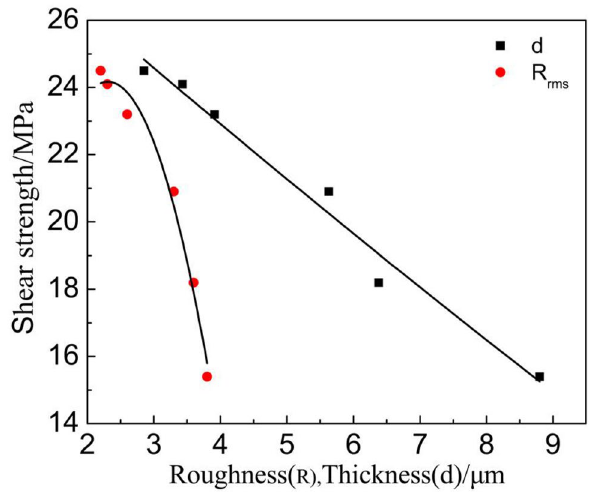
Figure 12. Relationship between shear strength and d, R rms .